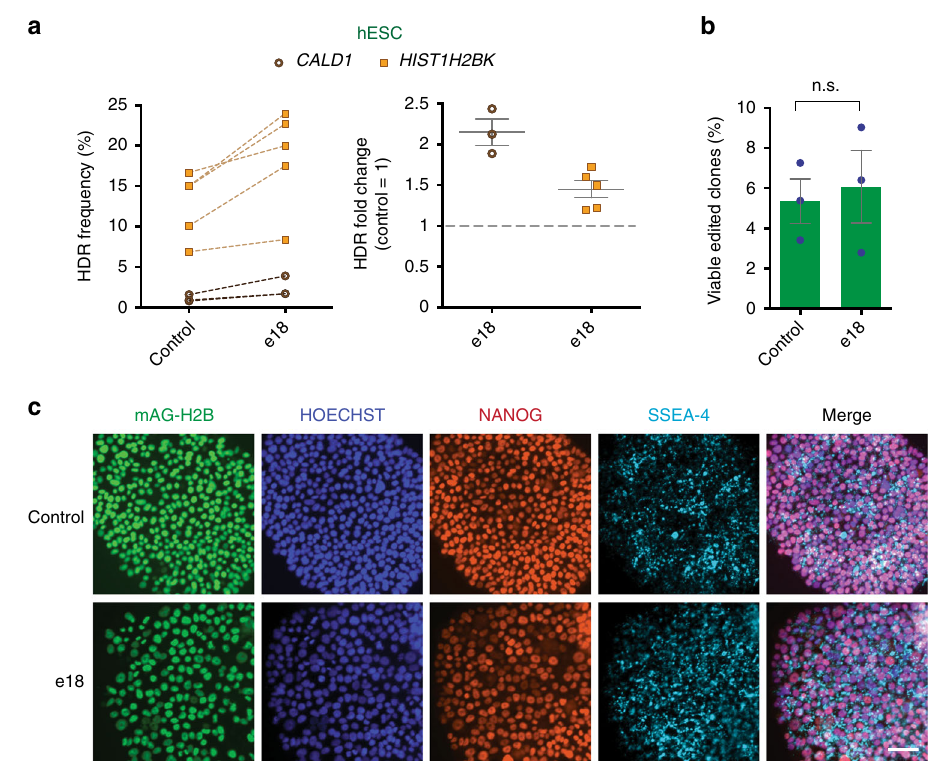
Fig. 6 Targeting of endogenous loci in hESCs. a Gene targeting ef fi ciency at the CALD1 (brown) and HIST1H2BK (yellow) loci in hESCs pES12 transfected with a CALD1 ssODN or a HIST1H2BK-mAG plasmid donor, respectively, along with vectors expressing Cas9 and sgRNA, and either a plasmid expressing e18 or an empty vector control. Gene targeting ef fi ciency at the CALD1 and HIST1H2BK loci was determined by NGS and fl ow cytometry (mAG + cells), respectively. Experiments were performed 5 days after transfection. HDR values are represented as in Fig. 5b ( HIST1H2BK , n = 5; CALD1 , n = 3). b Percentage of viable mAG + hESC pES12 clones 14 days after transfection with Cas9/sgRNA-expressing vectors, mAG dsDNA donor targeting the HIST1H2BK locus, and either an empty or e18-expressing plasmid. The values of individual experiments are presented along with the mean ± s.e.m. ( n = 3). Statistical signi fi cance was calculated using a paired t -test. c Immunostaining of pES12 cells edited at the HIST1H2BK locus using mAG dsDNA donors with or without e18 expression, as shown in a . Cell were stained using antibodies against the pluripotency markers NANOG (red) and SSEA-4 (cyan). mAG- tagged H2B is shown in green. Hoechst was used to detect DNA nuclei (blue). Merged images are also shown. Experiments were performed 5 days